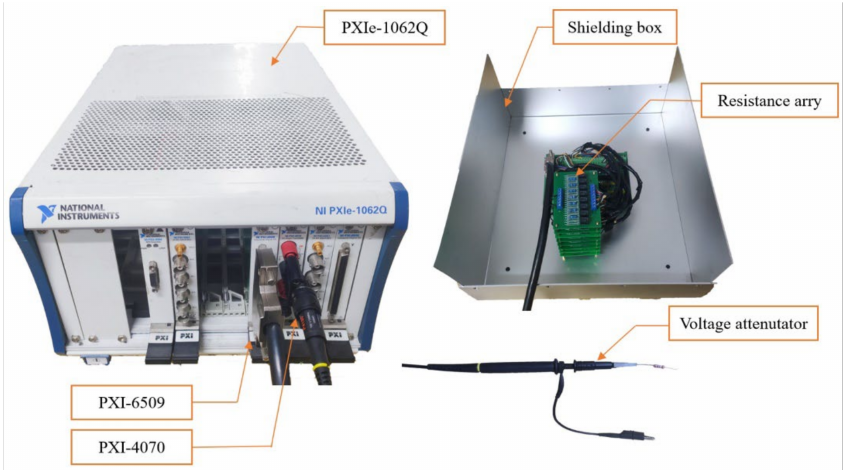
Figure 4. The APEW